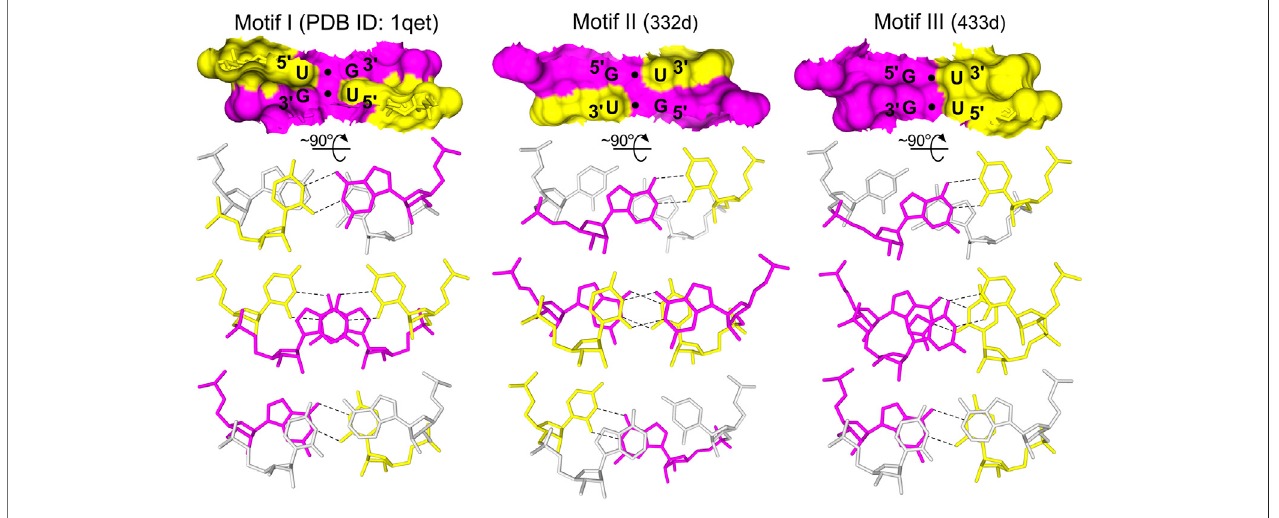
(cid:129) FIGURE1| Thethreetypes ofG Utandemmotifs.Thetandem motifs areshownassurfacerepresentationsbasedontheNMRand X-raystructures (Biswasand Sundaralingam, 1997; McDowell et al., 1997; Trikha et al., 1999). The stacking pattern characteristic for each motif is shown, including the base pairs fl anking the G (cid:129) tandems ( gray ). In G U tandems, G is magenta and U is yellow . Hydrogen bonds ( black dashed lines ) are presented only for G